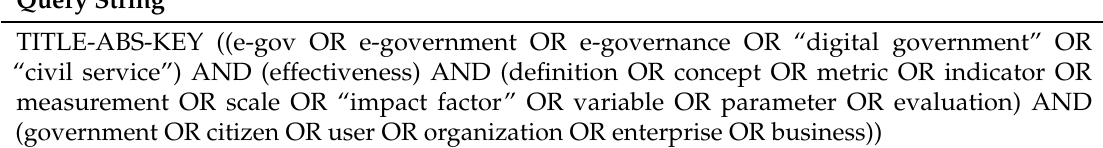
Table 1. Initial search string.